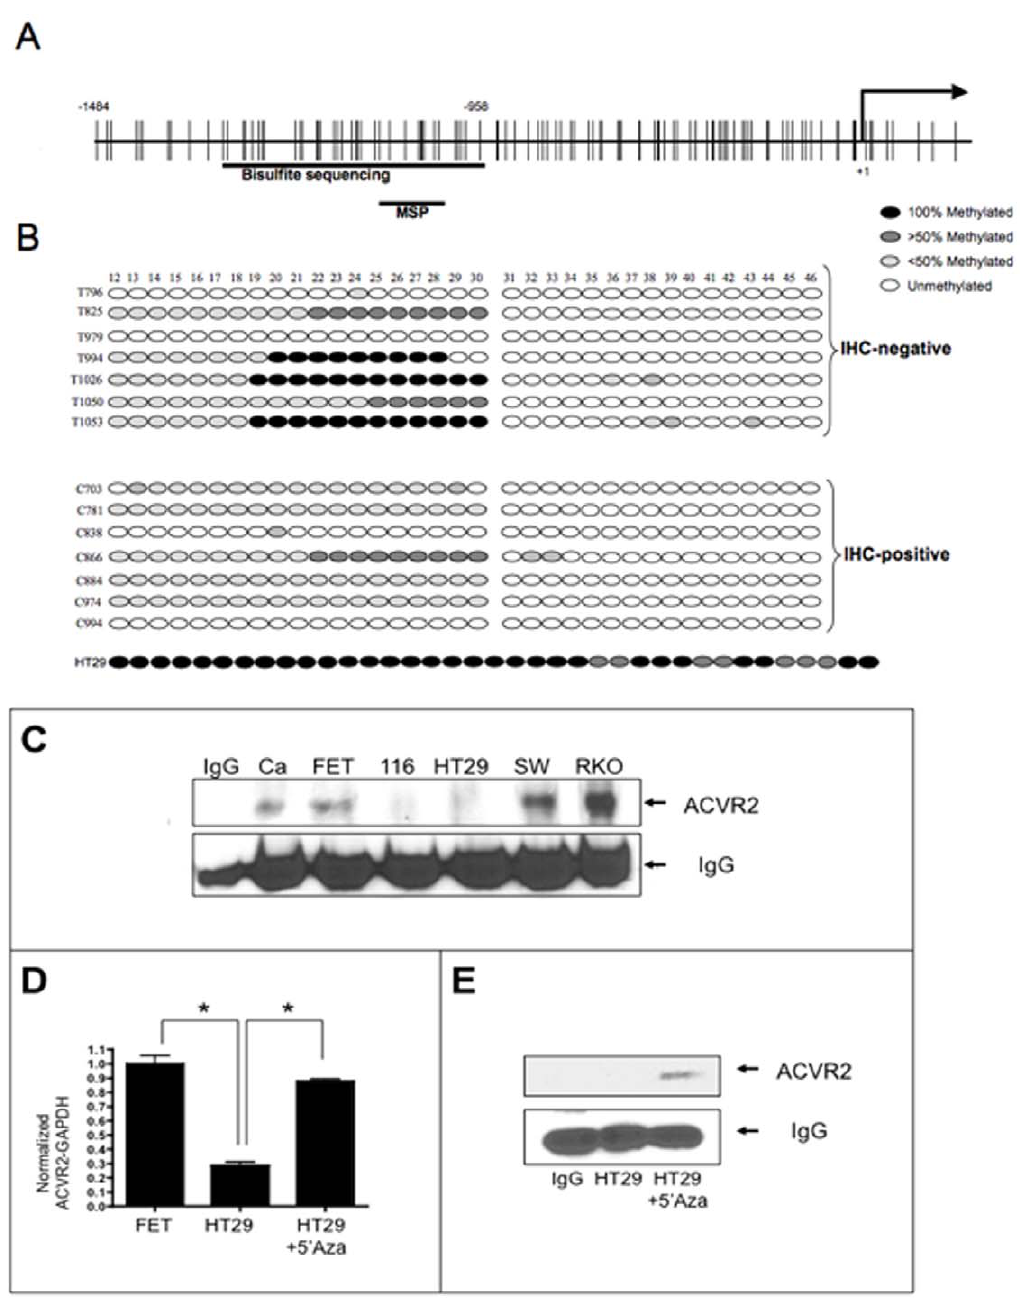
Figure 3. ACVR2 promoter hypermethylation and LOH in colon cancer specimens and the MSS HT29 cell line and correlation of ACVR2 promoter hypermethylation and loss of ACVR2 expression. A) ACVR2 promoter with map of positioning of MSP primers B) Using a CpG islands search program, we identified the CpG islands within the ACVR2 promoter based upon following stringent criteria: , CG percentage . 55%; observed CpG/expected CpG . 0.65; length . 500 bp. All CpG dinucleotide sequences are represented by vertical bars across the horizontal line depicting the promoter sequence. Each circle in the bottom panel illustrates an individual CpG site corresponding to the vertical bars depicted in the upper panel. Based upon bisulfite sequencing, each CpG site was scored quantitatively as 100% methylated (dark circles), . 50% methylated (dark grey circles), , 50% methylated (light grey circles) or unmethylated (white circles). As indicated, 3 of 7 ACVR2-negative CRCs demonstrated complete methylation of the critical region of ACVR2 promoter, while none of the ACVR2-expressing tumors showed any evidence for high degree/complete methylation of ACVR2 promoter. A methylation pattern similar to that seen in ACVR2 negative colon cancers was observed in the MSS colon cancer cell line HT29 with genomic DNA from HT-29 allowing for sequencing of a slightly larger region of the ACVR2 promoter. C) Six colon cancer cell lines with different microsatellite instability backgrounds (see Table 3) were analyzed for ACVR2 protein expression using immunoprecipitation techniques. Two cell lines, HCT116 (an MSI colon cancer cell line with biallelic frameshift mutations in ACVR2 ) and the MSS colon cancer cell line HT29 (with ACVR2 promoter hypermethylation), revealed loss of ACVR2 protein expression. D) Loss of ACVR2 protein expression correlated with decrease in ACVR2 mRNA transcription via quantitative PCR in HT29 cells when compared to the ACVR2 expressing cell line FET using GAPDH for standardization. This experiment was performed three times in triplicates, and the bar graph represents one experiment with * indicating a statistically significant difference with a p , 0.001. E) ACVR2 protein expression was re-established following demethylation treatment with 5 9 Aza.